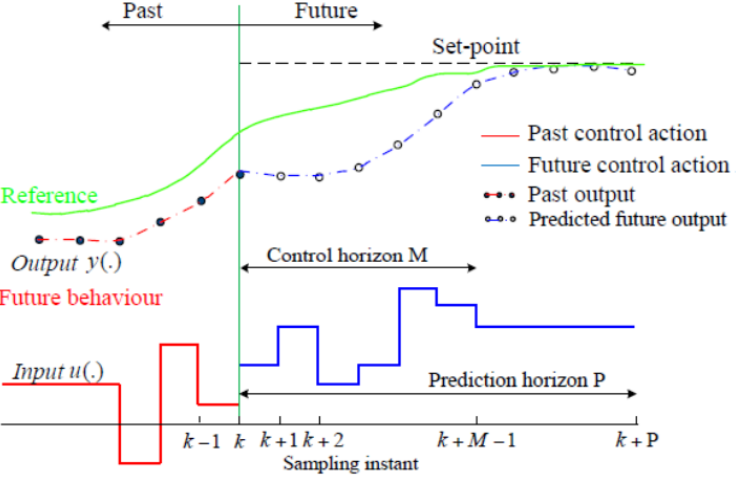
Figure 4. MPC controller parameter